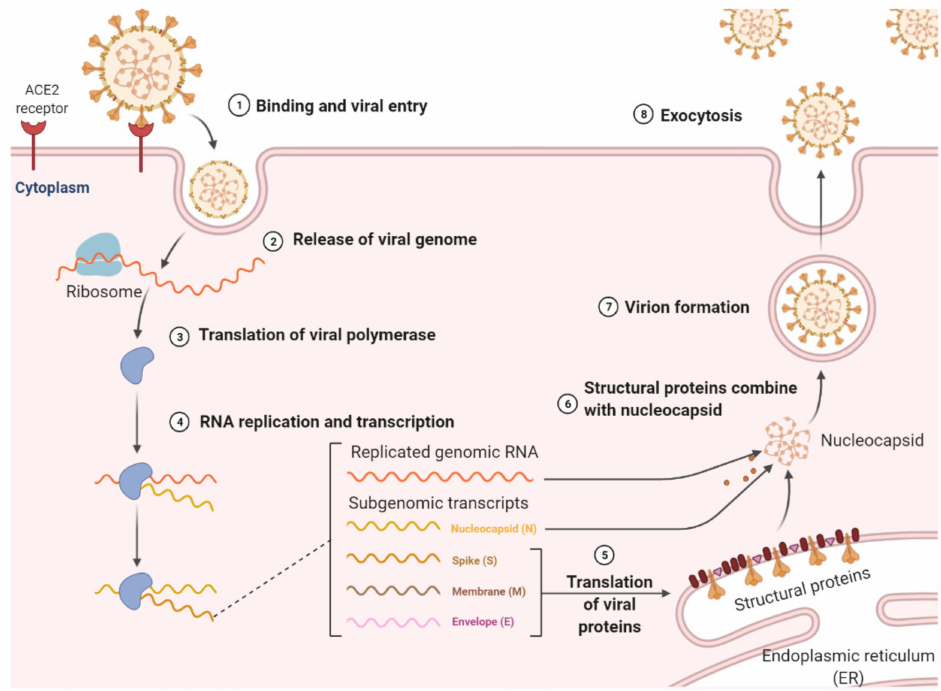
Figure 1. Life cycle of SARS-CoV-2. SARS-CoV-2 attaches to the host cell through the ACE2 receptor. It is internalized and its RNA is released into the cytoplasm where genome replication and translation of viral structural and accessory proteins occurs. After assembly, mature virion particles are released by exocytosis. Created with BioRender.com (accessed on 28 June